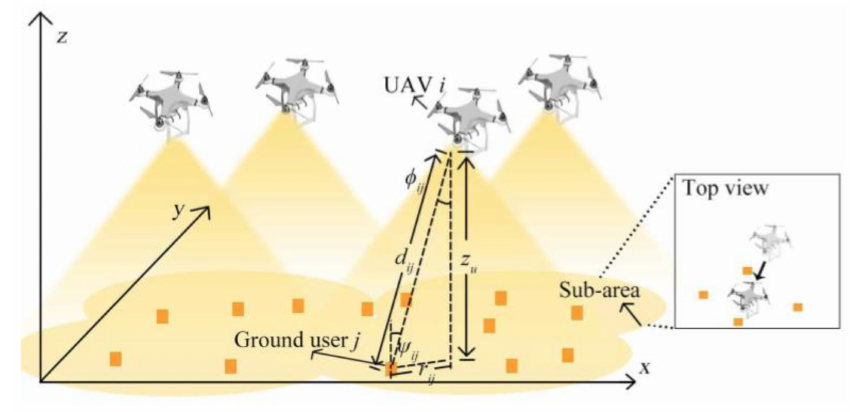
Figure 9. UAV and ground fixed terminal communication scene diagram